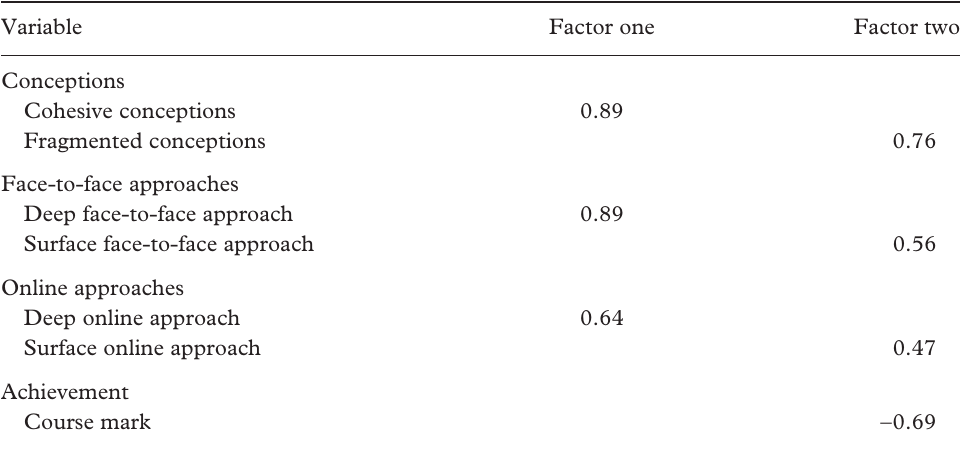
Table 3. Principal components factor analysis of conceptions, approaches and